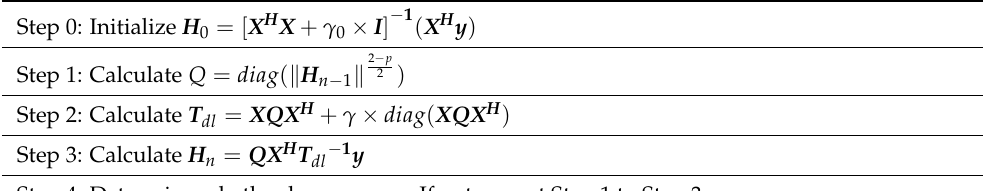
Table 2. The flow chart of diagonal loading IRLS